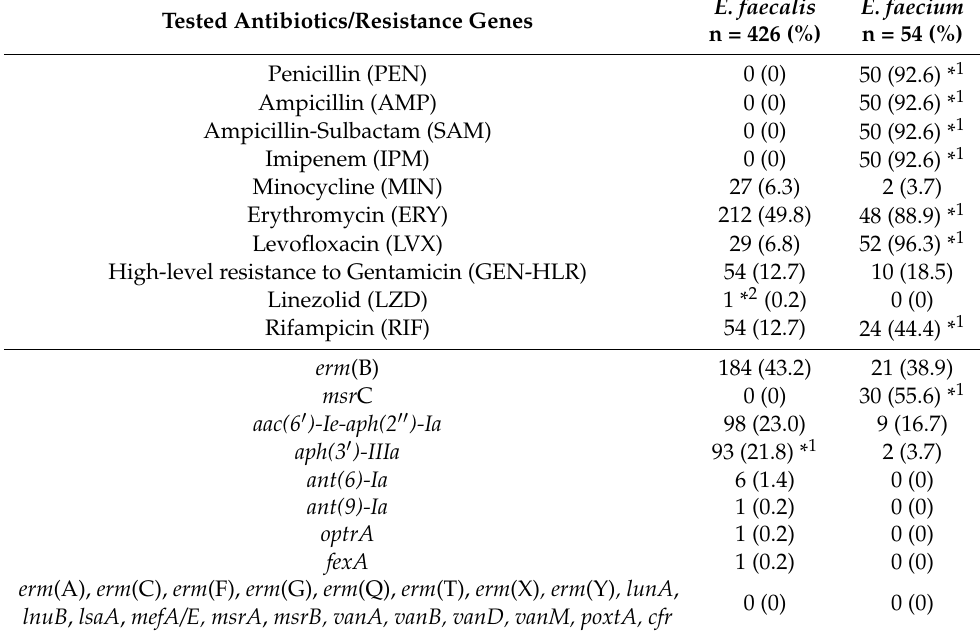
Table 2. Prevalence of antimicrobial resistance and resistance genes in clinical isolates of E. faecalis (n = 426) and E. faecium (n = 54).